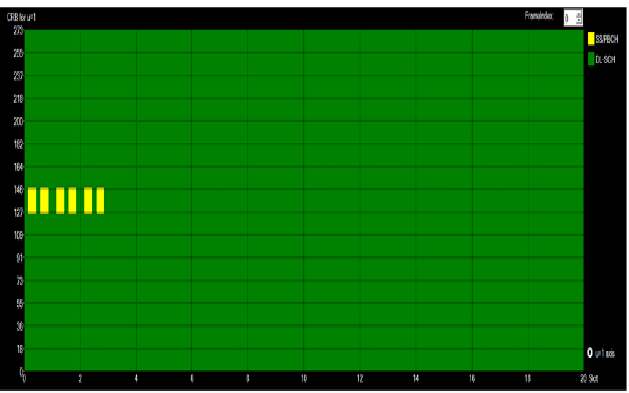
Figure 7. FDD signal #1 (FDD) frame structure. Green blocks represent the resources allocated to data transmission.